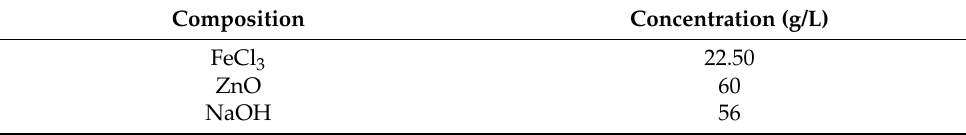
Table 2. Chemical composition of the zincate bath used on the Al substrate before the EL-deposition process.